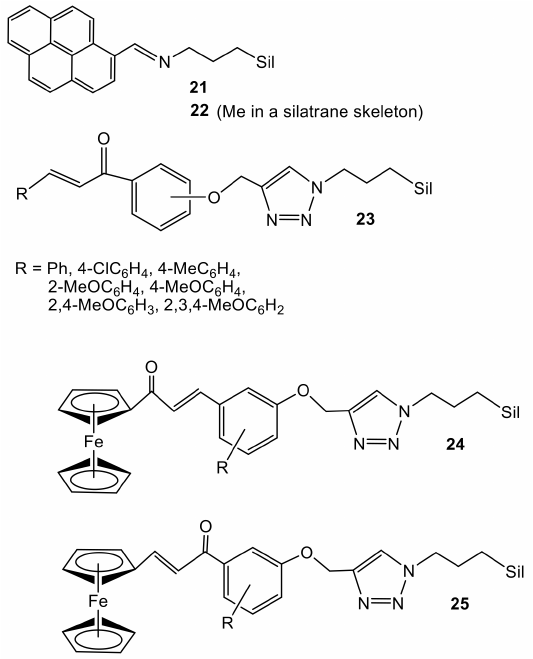
Figure 6. Chemical structures of silatranyl antiparasitic agents ( 21 – 25